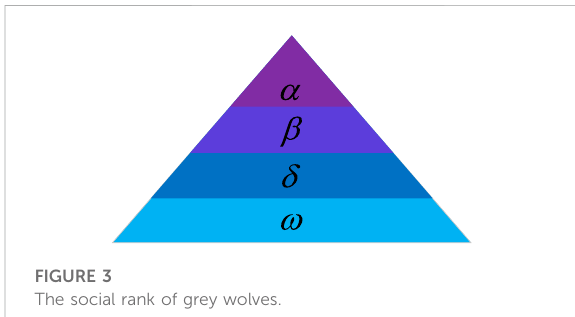
FIGURE 3 The social rank of grey